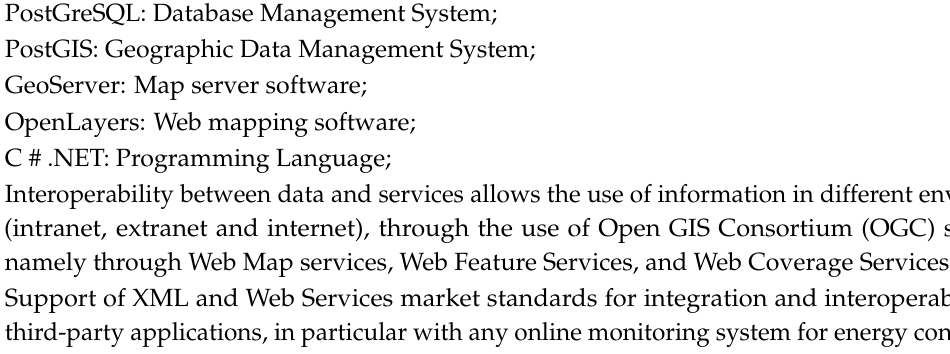
Figure 9. WebGIS architecture.